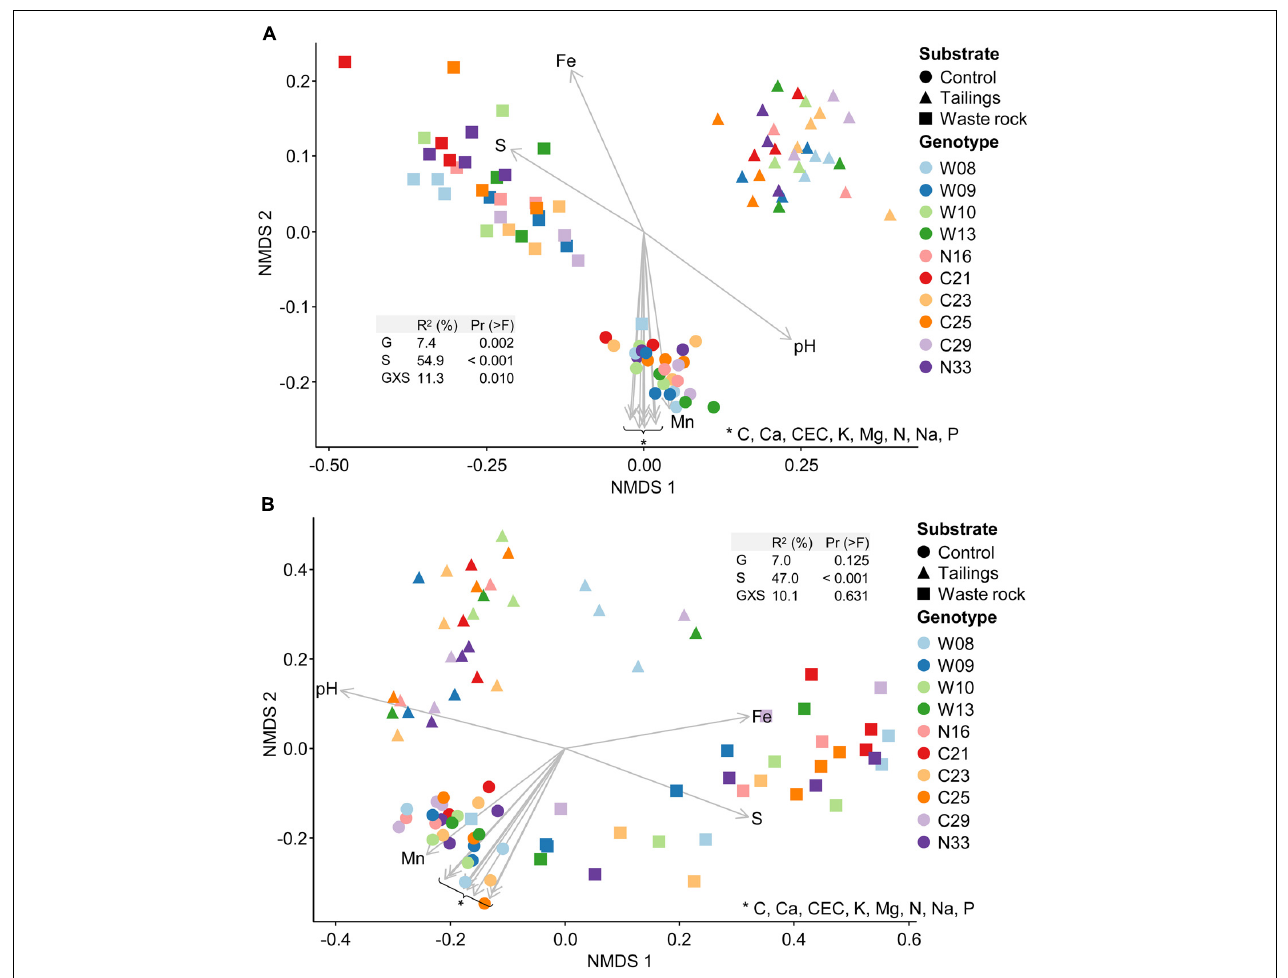
FIGURE 5 | Non-metric multidimensional scaling (NMDS) ordination of variation in bacterial and fungal community structure of balsam poplar rhizosphere in the greenhouse experiment. Bacterial community (A) and fungal community (B) . Points represent samples and arrows represent the significant ( p < 0.001) correlations between NMDS axes and the physicochemical properties of the substrates. In PERMANOVA tables, G is for genotype; S for substrate type and GXS for the interaction between genotype and substrate type. The model explains 73.6 and 64.1% of the variation in bacterial and fungal community structure, respectively ( n ≥